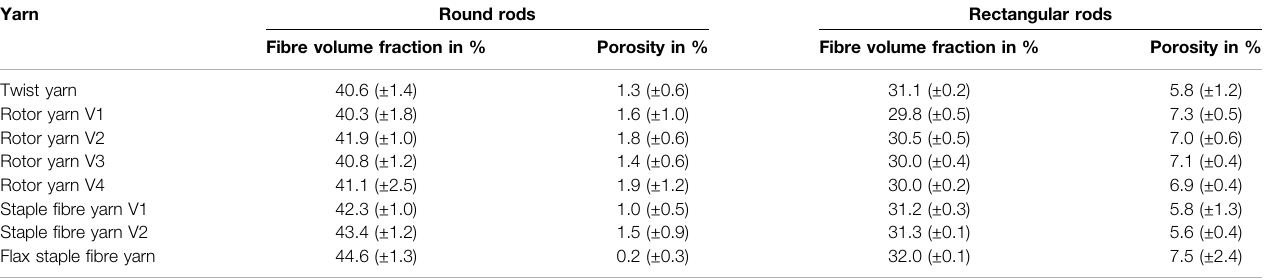
TABLE 1 | Mean fi bre volume fraction (standard deviation in brackets) and porosity of pultruded round and rectangular rods. Yarn Round rods